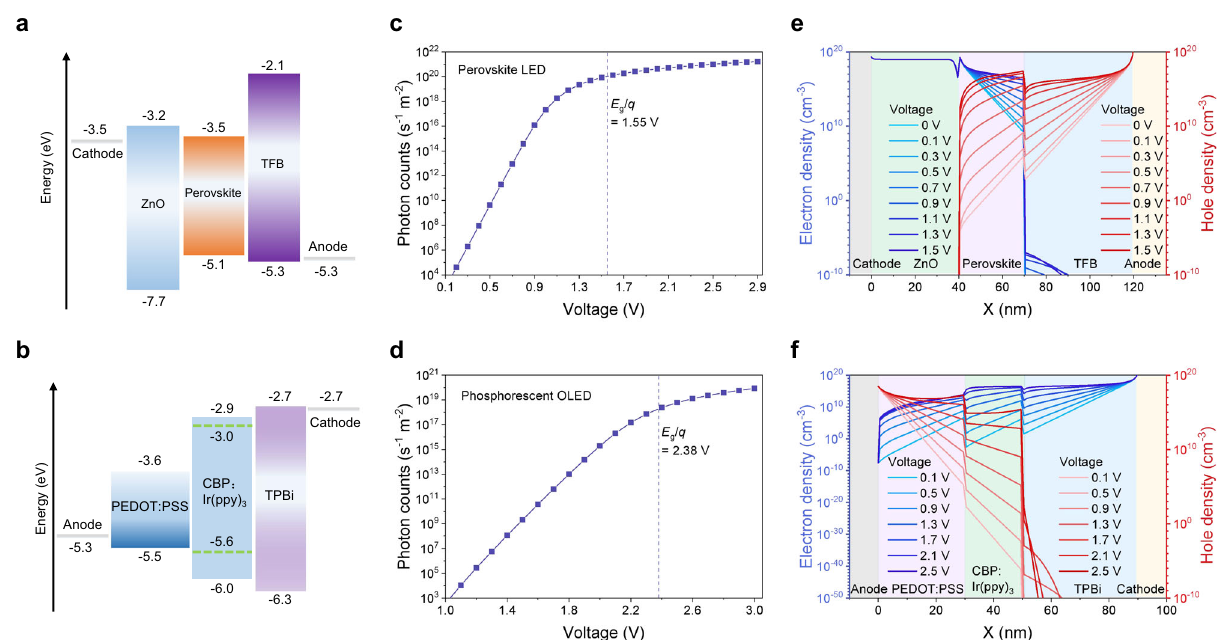
Fig. 4 Device simulations of lead-iodide perovskite LED and Ir(ppy) 3 phosphorescent OLED using Setfos. a Energy level diagram of a lead-iodide perovskite LED. b Energy level diagram of a Ir(ppy) 3 OLED. c Simulated EL intensity-voltage characteristics of a lead-iodide perovskite LED. d Simulated EL intensity-voltage characteristics of a Ir(ppy) 3 OLED. e Simulated electron and hole density distributions in the perovskite LED under different voltages. The shaded regions in grey, light green, pink, light blue and yellow correspond to cathode, ZnO, perovskite, TFB and anode, respectively. f Simulated electron and hole density distributions in the Ir(ppy) 3 OLED under different voltages. The shaded regions in grey, pink, light green, light blue and yellow correspond to anode, PEDOT:PSS, CBP:Ir(ppy) 3 , TPBi and cathode, respectively.